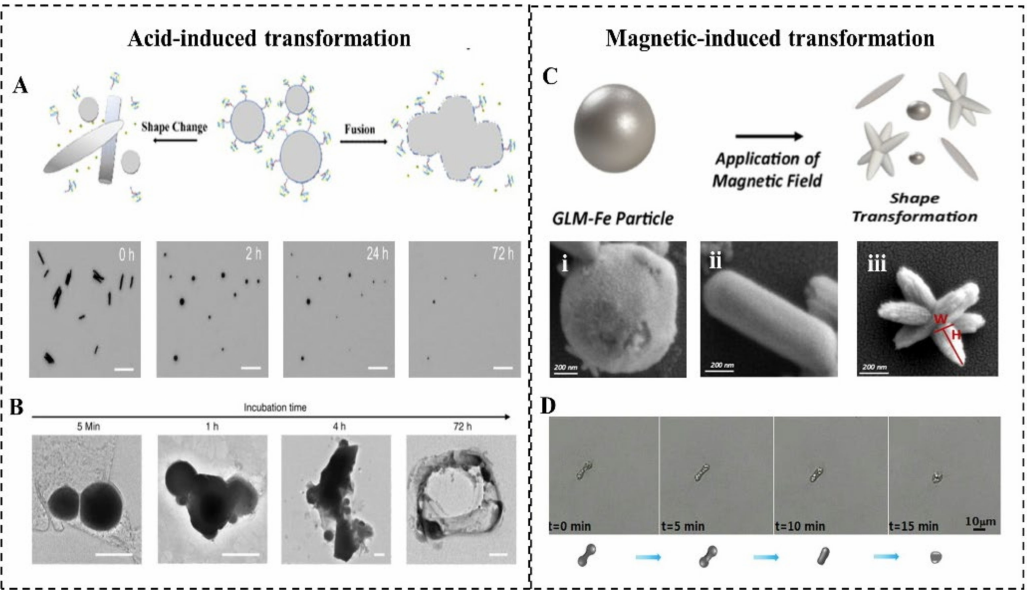
Figure 4. Acid-induced and magnetic-induced morphological transformation. ( A ) Schematic changes and time-lapse images (Scale bars, 10 µ m) induced by acid including shape change and fusion of the LMNPs [9,78]. ( B ) Representative TEM images of LM LMNPs loaded with Dox after different incubation times immersed in acidic (pH = 5.0) PBS buffer. The scale bars are 100 nm (for 5 min, 1 h, 4 h) and 400 nm (for 72 h) [77]. ( C ) Schematic changes and SEM images of magnetic Galinstan particle transformed in three morphological categories following magnetization: ( i ) Spheroids, ( ii ) rods, and ( iii ) stars [22]. ( D ) Time-lapse images represents efficient morphological transformation of for micro/nano LM motors (MCLMTs) with an alternating magnetic field (AMF)-irradiation (~20 kHz, average power Pav = 2 kW)